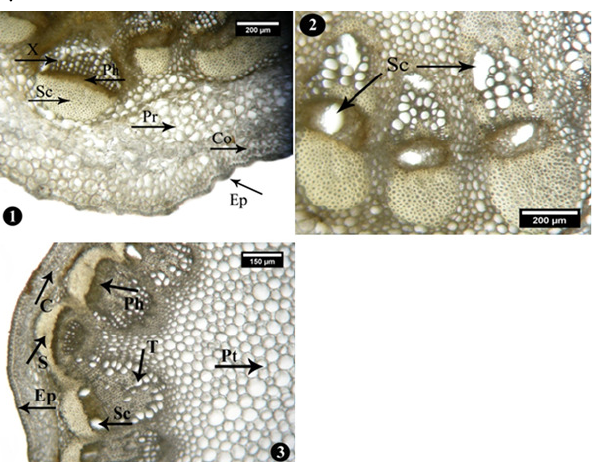
Fig. 2. Cross-section of stem of Inula species. 1-2. I. helenium